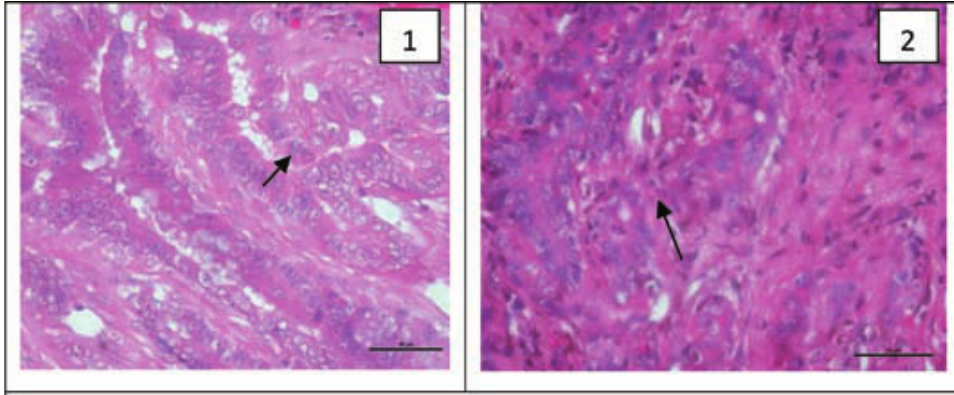
Fig.1. Histopathological observations of the two samples of CMT